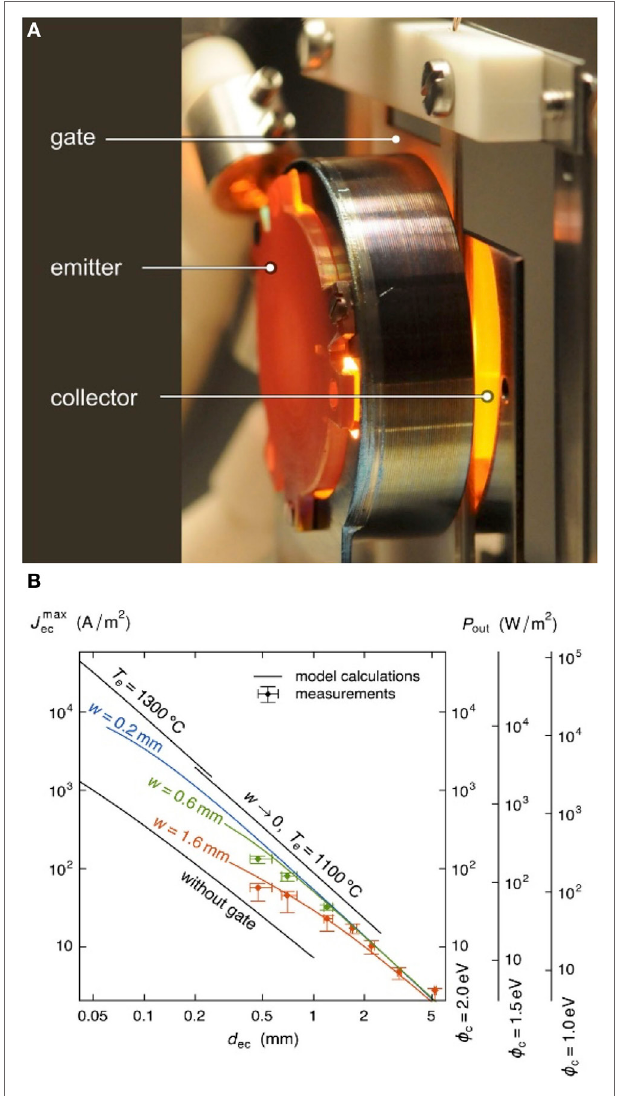
FigURe 5 | Using gates to solve the space-charge problem. In thermo- electronic generators as shown in panel (A) , a gate voltage allows efficient operation at large emitter–collector spacings, d ec . (B) Measured data (data points) together with the results of numerical simulations (lines) for various hole diameters ( w ) of the gate. Adapted from Meir et al. (2013) under Creative Commons Attribution